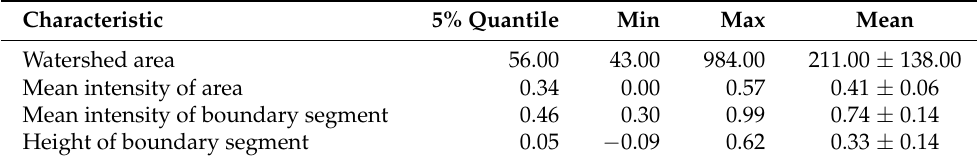
Table A1. Statistics of some quantities of interest related to the intensity of boundary segments and regions. These quantities allow us to define heuristics to identify erroneous segmentations computed by the watershed algorithm. We state the characteristic and report the minimum, maximum 5% quantile, mean, and standard deviation for the reported quantities of interest. Characteristic 5% Quantile Min Max Mean Watershed area